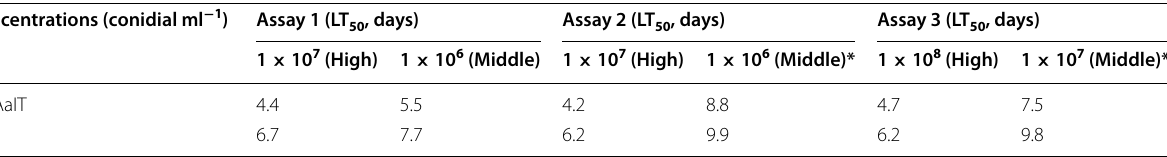
* The difference of LT 50 for two strains is not significant